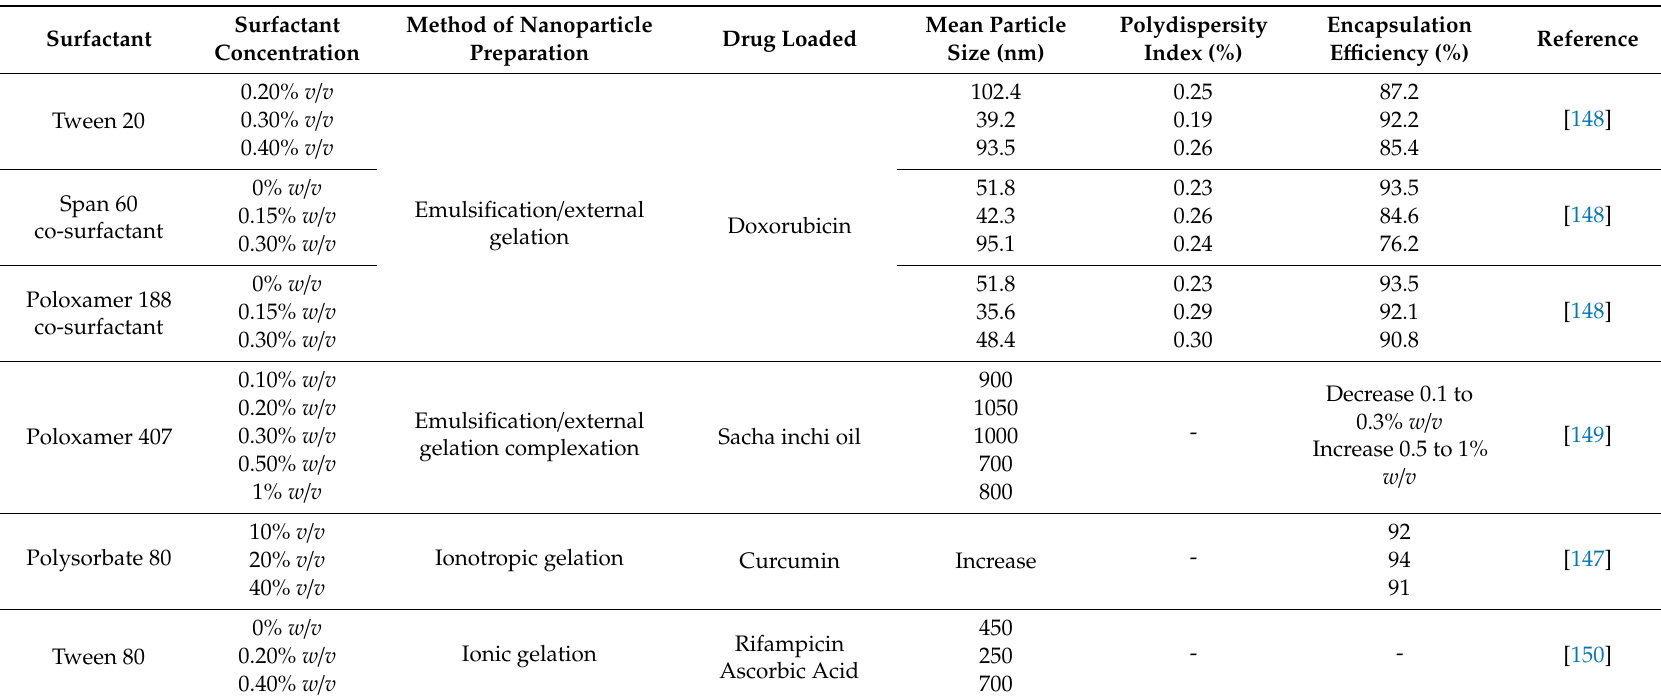
Table 4. The influence of surfactant type / concentration on alginate